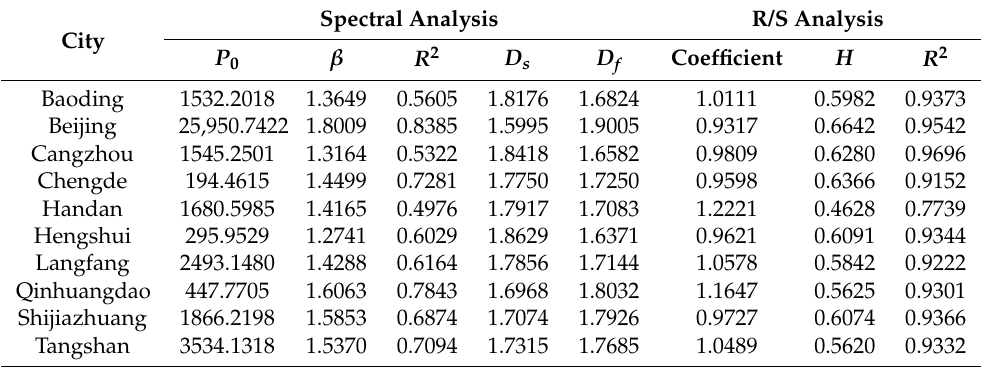
Table 3. The power spectrum exponents, fractal dimension, and Hurst exponent of Chinese cities in Beijing-Tianjin-Hebei region based on time series of night light data